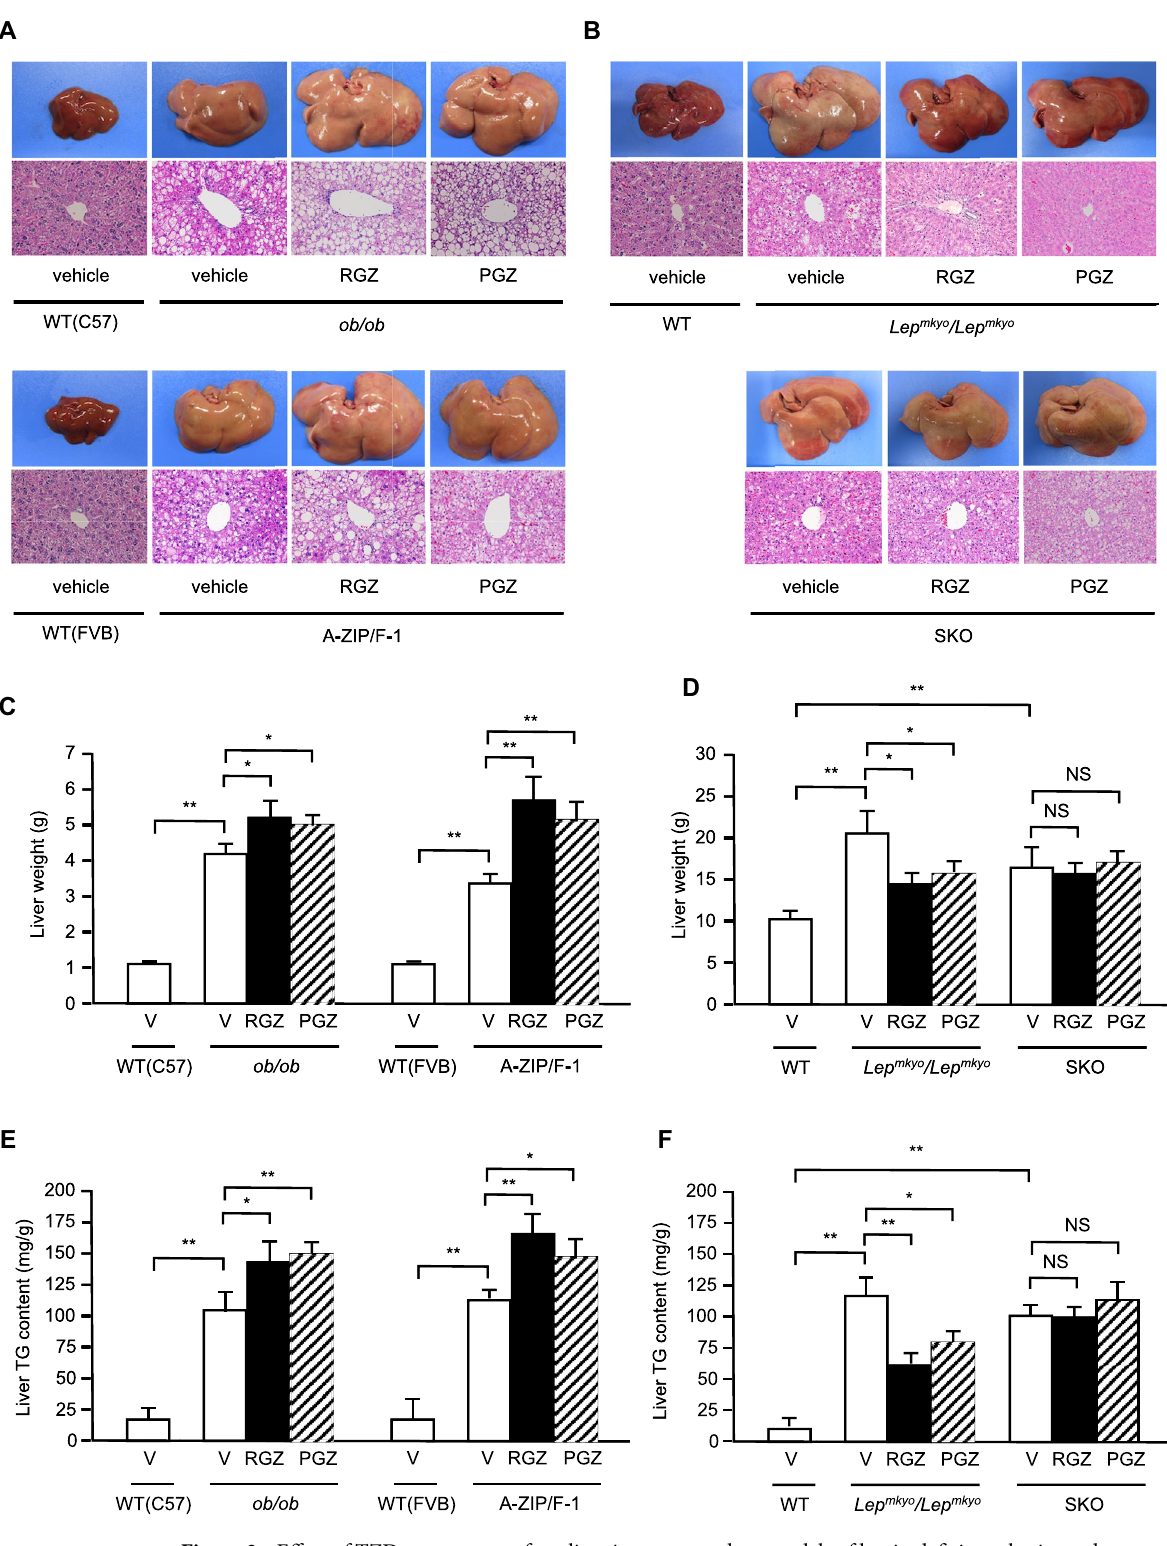
Figure 2. Effect of TZD treatment on fatty liver in mouse and rat models of leptin deficient obesity and generalized lipodystrophy. ( A , B ) Macroscopic (top) and histological images (bottom) of the liver, ( C , D ) liver weight and ( E , F ) liver triglyceride content in C57B/6J WT, ob/ob , FVB/N WT and A-ZIP/F-1 mice ( A , C , E ) and F344 WT, Lep mkyo /Lep mkyo and SKO rats ( B , D , F ) treated with vehicle, RGZ or PGZ. For histological examination, hematoxylin and eosin staining was used. Original magnification of × 200 is shown. For liver weight and liver triglyceride content, values are means ± SEM ( n = 10 per group). * P < 0.05, ** P < 0.01, NS, not significant (one- way ANOVA followed by Tukey’s